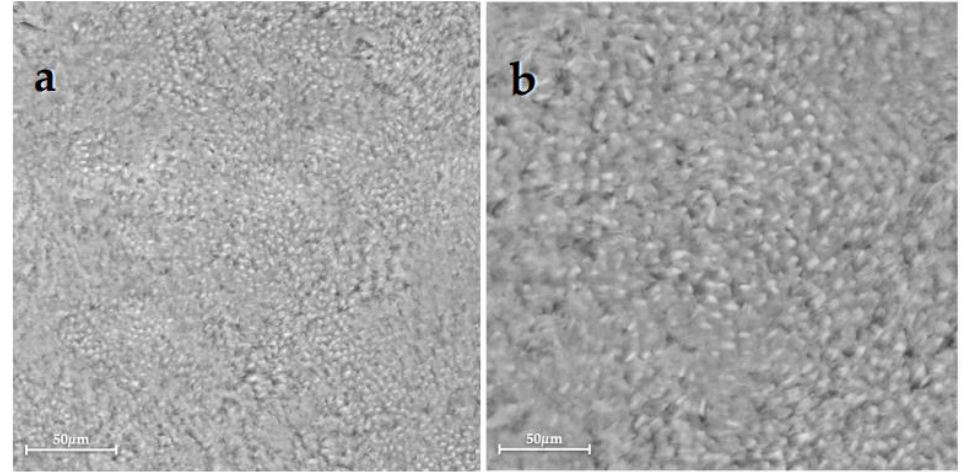
Figure 4. Scanning electron micrographs of Group 4 ( a ) at 500 × magnification, showing the presence of a homogeneous enamel surface with an apparent structural reconstitution; and ( b ) at 1000 × magnification, showing enamel prisms with partially intact crystals.